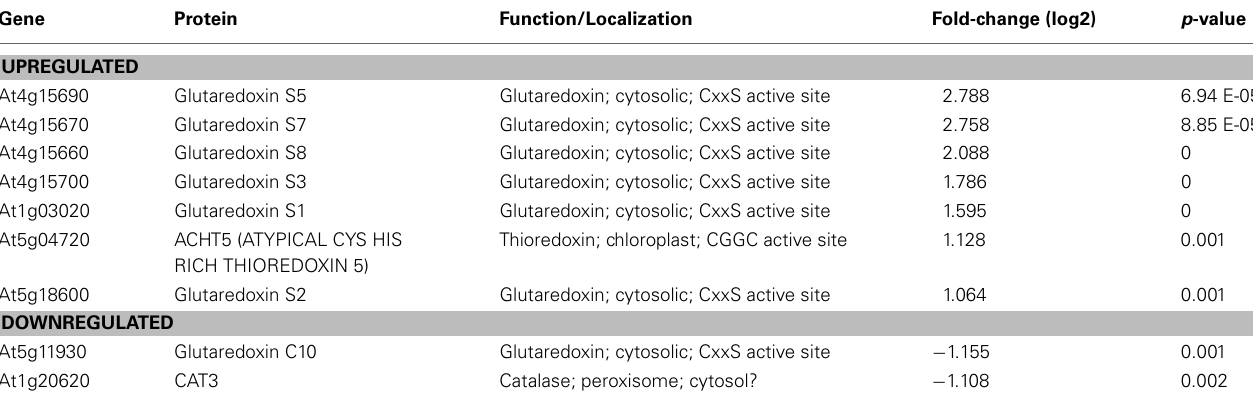
Table 2 | Changes in “Redox” Transcripts in hot5-2 vs. wild-type.